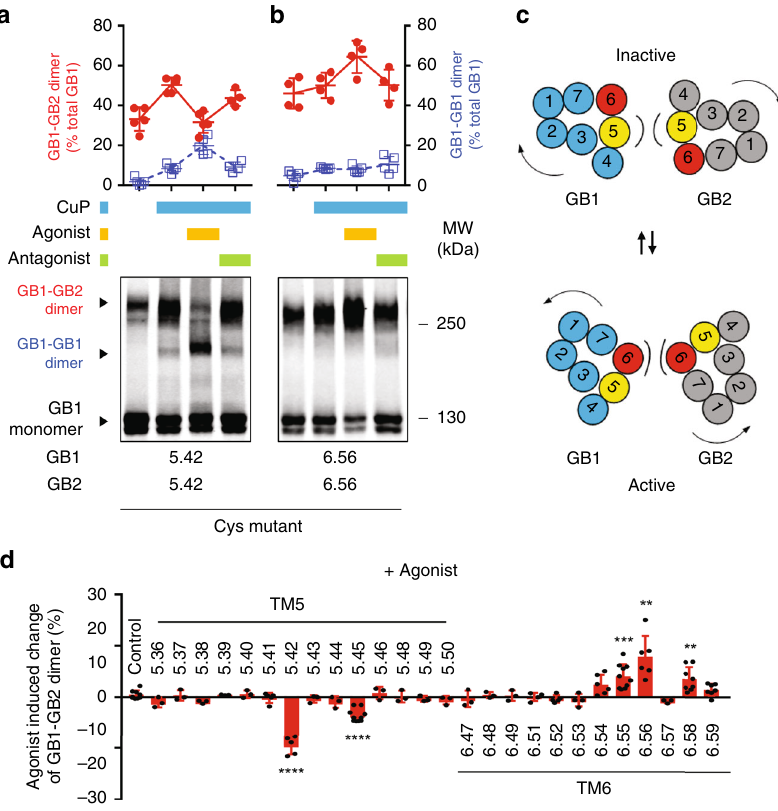
Fig. 3 The interface of the heterodimer is switched from TM5 to TM6 during activation. a , b The cell surface SNAP-GB1 containing the indicated single cysteine substitution was cross-linked with the indicated GB2 cysteine mutant. The results were obtained for the symmetric interface TM5 and TM6, after pre-incubation with the agonist GABA or the competitive antagonist CGP54626 and with CuP. The percentage of GB1-GB2 heterodimers (in red) and GB1- GB1 homodimers (in blue) relative to the total amount of GB1 subunit was quanti fi ed by imaging the fl uorescent blots. c Change of GB1-GB2 dimer rate induced by the agonist and determined by GB1-GB2 dimer quanti fi cation before and after GABA treatment. Data are mean ± SD from at least three independent experiments ( n = 3 – 5). Unpaired t test with Welch ’ s correction with **** P < 0.0001, *** P < 0.001 and ** P < 0.01, the other data being not signi fi cant. GABA and CGP54626 were used at 100 μ M. d Model highlighting the TMs involved in the dimerization of GB1-GB2 heterodimers in the inactive state (TM5, yellow) and in the active state (TM6,